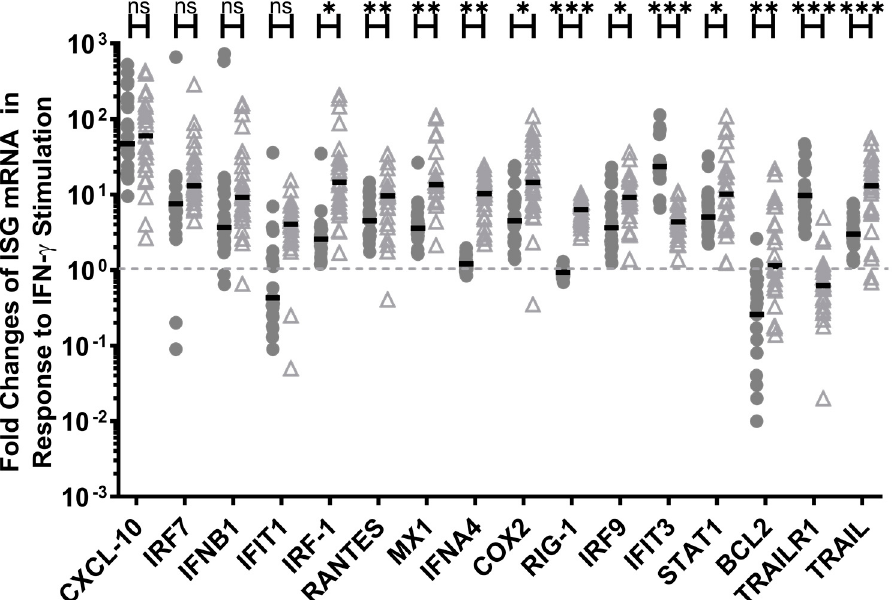
Figure 2. Changes in a subset of antiviral ISG gene expression in ex vivo PBMC, in response to exogenous IFN- γ stimulation. Three hours post-stimulation, cellular RNA transcript levels were quantitated using RT-qPCR, and total transcript levels were normalized to 18S rRNA. Multiple t -tests between the HESN ( • ) and the non-HESN ( (cid:52) ) groups were performed (Prism 9.0); n = 23 HESN, and n = 26 non-HESN controls. Median values ( - ) were shown for each group. * p -value < 0.05; ** p -value <0.01, *** p -value < 0.001; n.s. denotes ‘not statistically significant’.